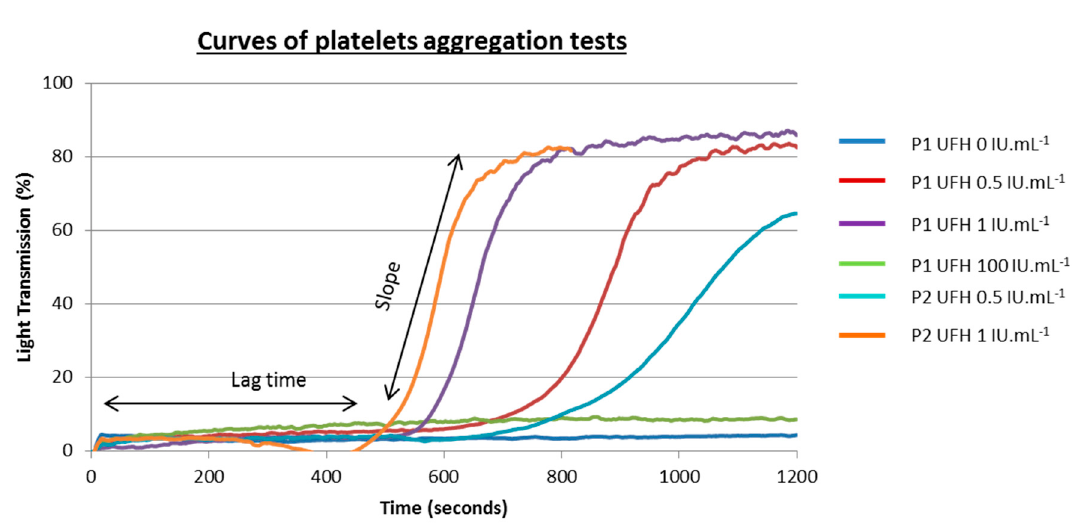
Figure 2. Typical tracings obtained with light transmission aggregometry (PAT) in the absence and in the presence of low (0.5 and 1 IU / mL) and high (10 IU / mL) unfractionated heparin UFH concentrations. Aggregation curves for two patients with HIT (P1 and P2) are presented here. Different lag times related to heparin concentrations and patient samples are presented. P1 antibodies appear to be more reactive than P2 antibodies.